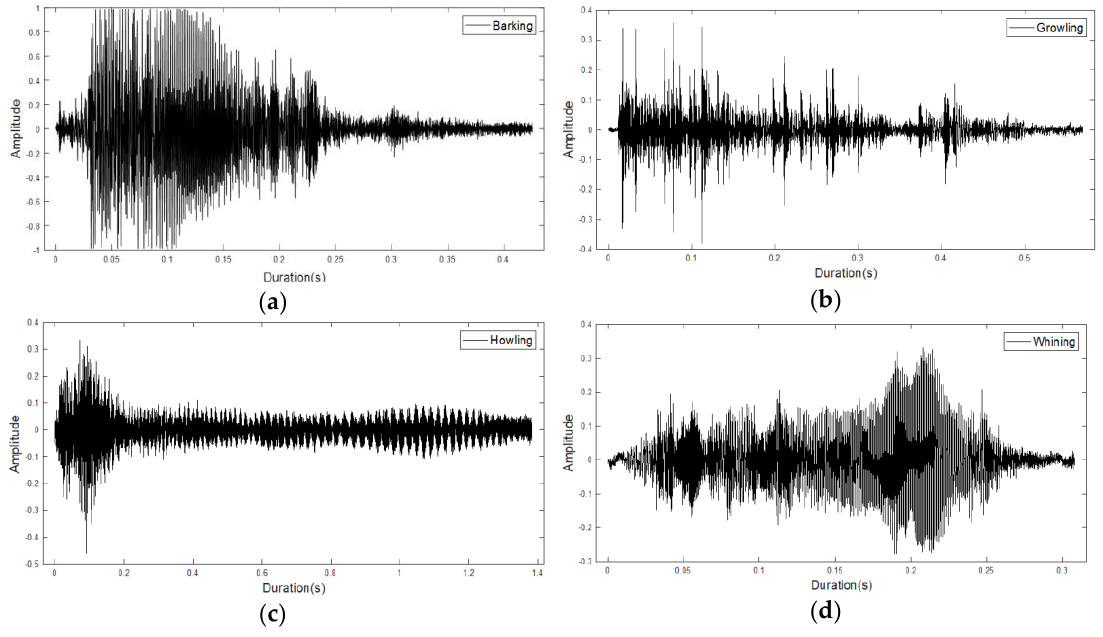
Figure 3. Waveforms for four pet dog sound events: ( a ) barking; ( b ) growling; ( c ) howling; ( d ) whining events.